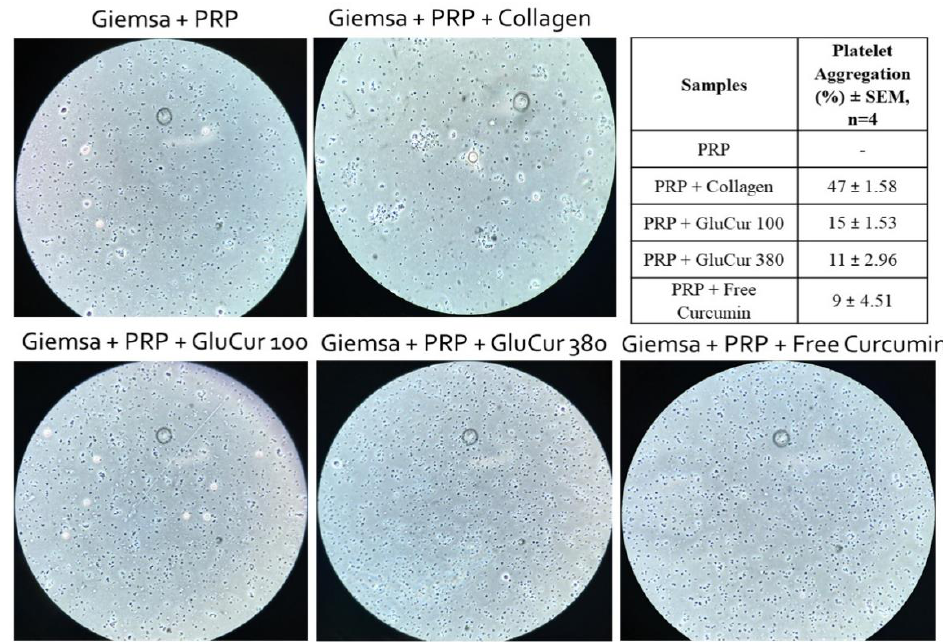
Figure 3. The evaluation of platelet aggregation by incubating platelet-rich plasma (PRP) with curcumin-loaded glucan NPs and free curcumin at 3.4 µg/mL for 30 min. Collagen (600 µg/mL) and PBS were used as the positive and negative controls, respectively. A platelet count was performed and the percentage is outlined in the table (mean ± SEM, n = 4). For the experiment, platelets were stained with Giemsa dye and visualized using an optical microscope.